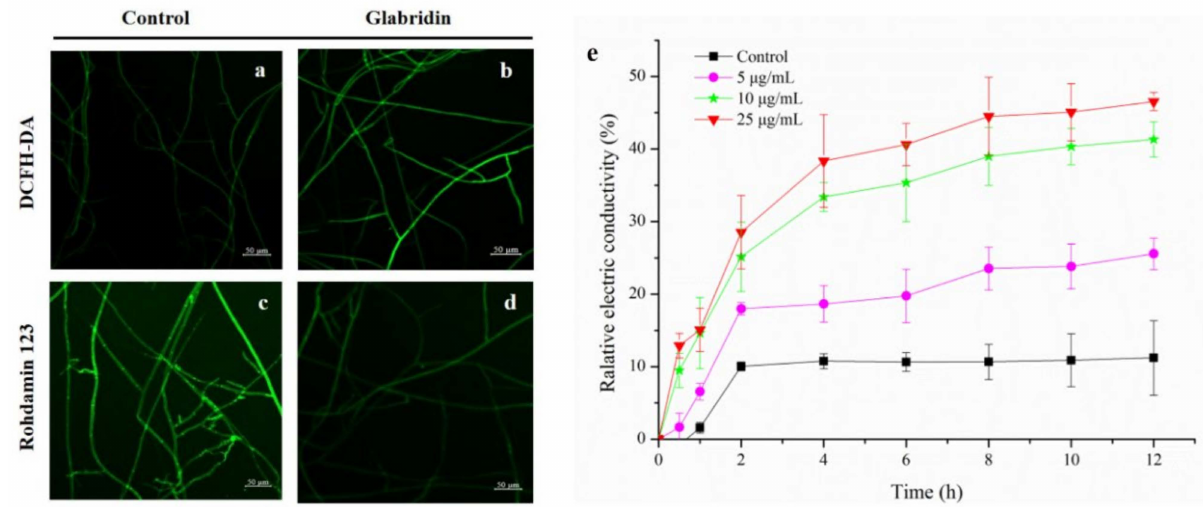
Figure 4. Effects of glabridin on the reactive oxygen species ( a , b ), mitochondrial membrane potential ( c , d ) and cell membrane permeability ( e ) of S. sclerotiorum mycelia. Data are displayed as the mean ± SD. The scale bar: 50 µ